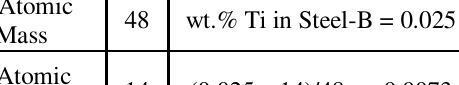
Table 2: Mathematical Calculation of Ti And N to form ALN Ti Atomic 48 wt.% Ti in Steel-B = 0.025 Mass N Atomic 14 (0.025 x 14)/48 = Mass